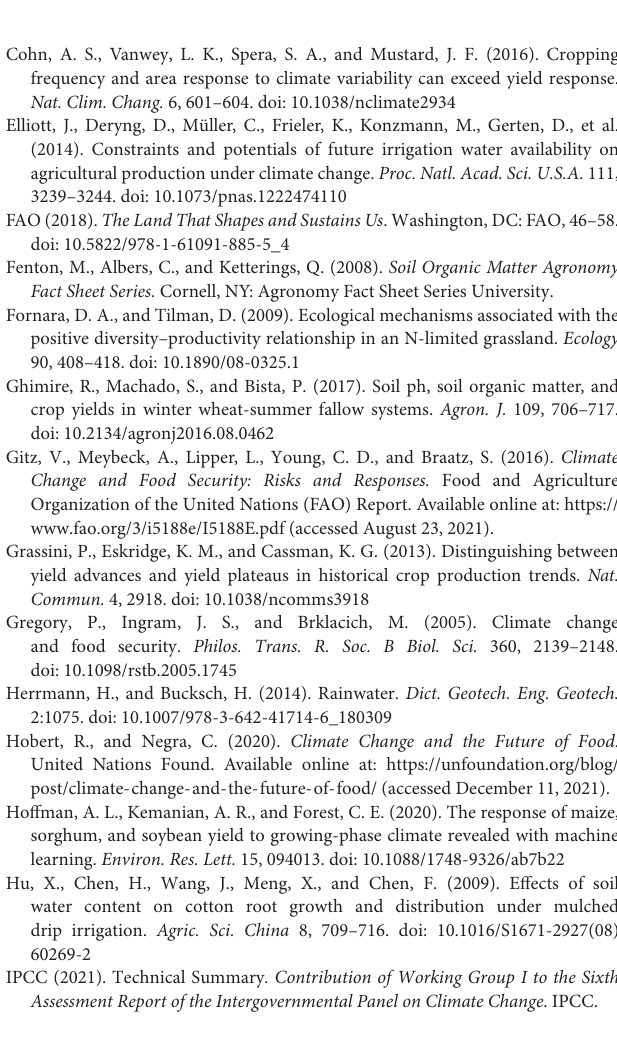
Supplementary Figure 9 | Feature ranks and overall weight of features following explainable machine learning interpretations for soybean for low, medium, and high quartiles of soil organic matter. Supplementary Figure 10 | Feature ranks and overall weight of features following explainable machine learning interpretations for cotton for low, medium, and high quartiles of soil organic matter. Supplementary Figure 11 | Feature ranks and overall weight of features following explainable machine learning interpretations for wheat for low, medium, and high quartiles of soil organic matter. Supplementary Figure 12 | Feature ranks and overall weight of features following explainable machine learning interpretations for corn for low, medium, and high quartiles of clay. Supplementary Figure 13 | Feature ranks and overall weight of features following explainable machine learning interpretations for soybean for low, medium, and high quartiles of clay. Supplementary Figure 14 | Feature ranks and overall weight of features following explainable machine learning interpretations for cotton for low, medium, and high quartiles of clay. Supplementary Figure 15 | Feature ranks and overall weight of features following explainable machine learning interpretations for wheat for low, medium, and high quartiles of